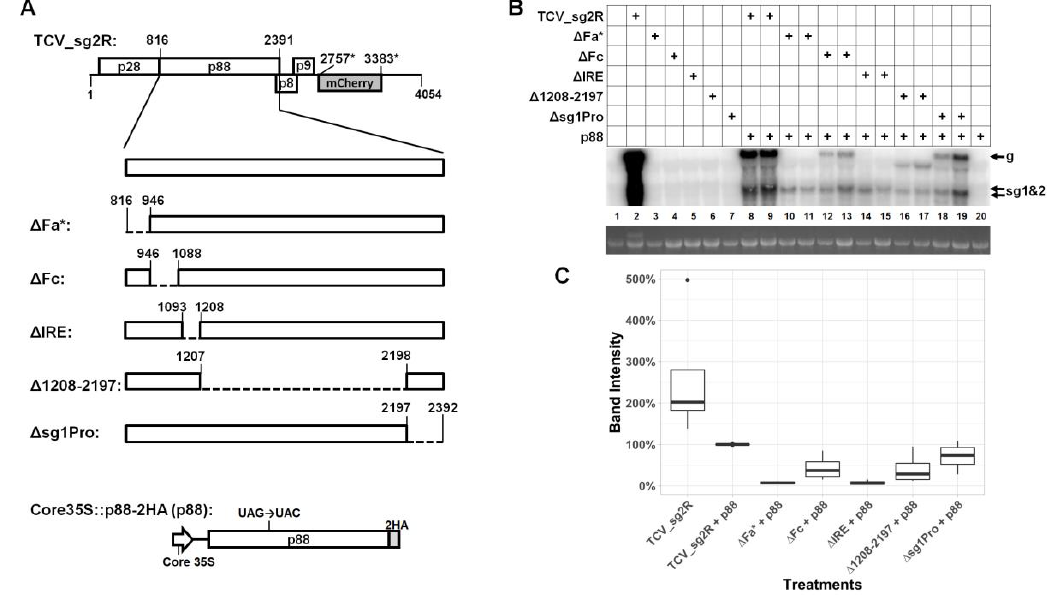
Figure 1. Deletions within the p88 coding sequence differentially affect the abundance of TCV gRNA in N. benthamiana cells. ( A ) Schematic representation of five in-frame deletions within the p88 coding sequence. The top diagram depicts the genome of TCV_sg2R, a derivative of TCV encoding mCherry in place of TCV CP. It is the backbone for all deletion and point mutants used in this study. The numbers are nucleotide positions in TCV gRNA. Dashed lines represent the regions deleted. ( B ) Results of a representative Northern blotting, showing the accumulation levels of different deletion mutants in the presence of trans-supplied p88. None of the mutants could replicate on their own. ( C ) Quantification of the gRNA accumulation levels of the deletion mutants. The box plots were based on relative intensity of the gRNA bands, derived from four repeats. The band intensity of (TCV_sg2R + p88) was set as the reference for comparison.